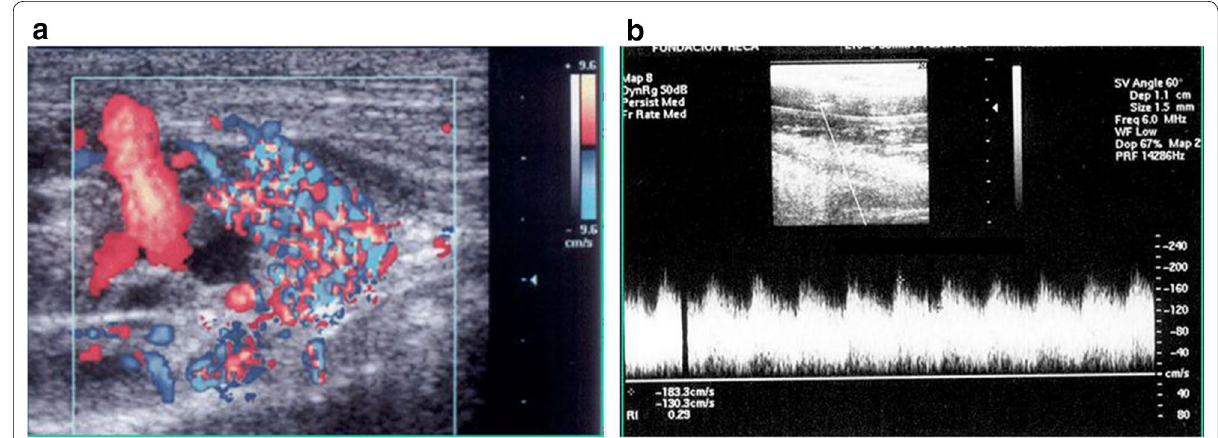
Fig. 17 Arterio venous fistula. a Color Doppler aspect: mosaic of colours representing multiple different velocities. b Spectral analysis: high systolic and diastolic